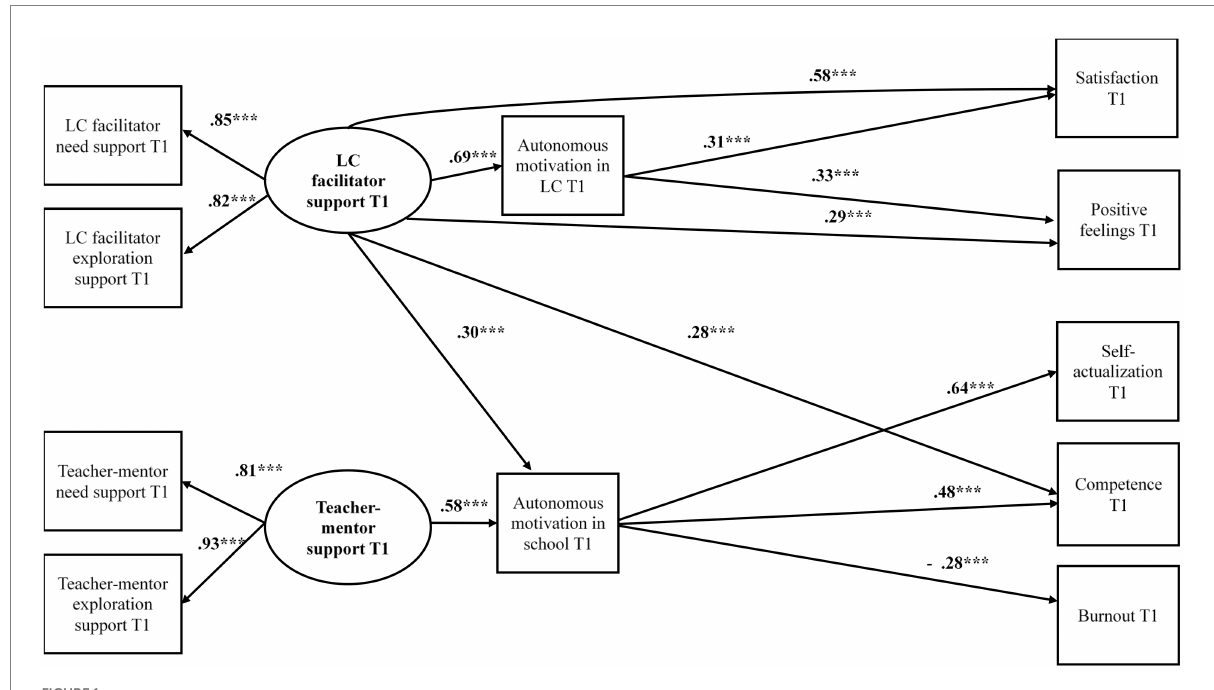
FIGURE 1 Results for the hypothesized structural model – T1. *** p